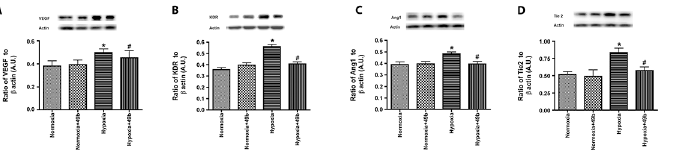
Fig 4. Protein levels of VEGF (A), KDR (VEGF receptor 2, B), Angiopoietin 1 (C) and Tie2 (D) from retinal endothelial cells cultured in normoxia or hypoxia only and cells in each condition treated with Compound 49b. Hypoxia increased protein levels of all proteins, which were significantly reduced after treatment with Compound 49b. Data is mean ± SEM. * P < 0.05 vs. normoxia. # P < 0.05 vs. hypoxia. N =